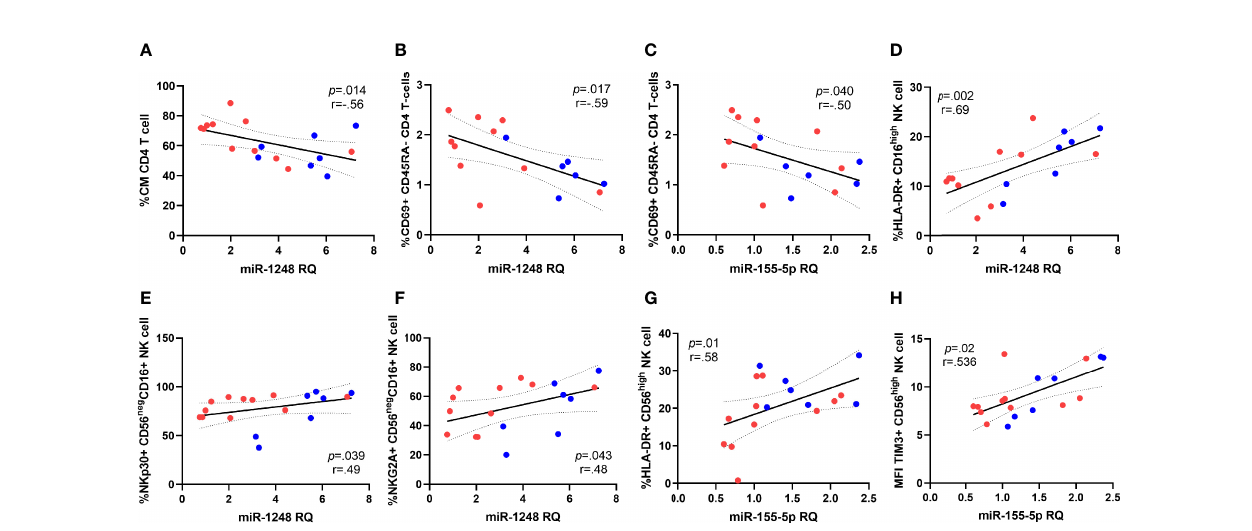
FIGURE 4 | Correlations between miRNAs and subset distribution and activation markers expression on CD4 T cells and NK cells. Correlations of miRNA-1248 relative quantity (RQ) with CD4 Central Memory subset distribution (CM, de fi ned as CD45RA-CD27+) (A) and CD69+ expression on CD45RA- CD4 T cells (B) , data available for 16 patients. MiRNA-155-5p correlations with CD69+ expression on CD45RA- CD4 T cells (C) , data available for 16 patients. Correlations of miRNA- 1248 levels and expression of HLA-DR on CD16 high NK subset (D) and NKp30 and NKG2A on CD56 neg CD16+ NK cell subset (E, F) . Correlations of with miRNA- 155-5p levels with HLA-DR expression on CD56 high NK cells (G) and median intensity fl uorescence (MFI) of TIM-3 expression on CD56 high NK cell subset (H) . Patients from EARLY treated group (n=7) are highlighted with blue dots and red dots represent LATE treated HIV-1-young adults (n=11). The Spearman rho correlation coef fi cient test was